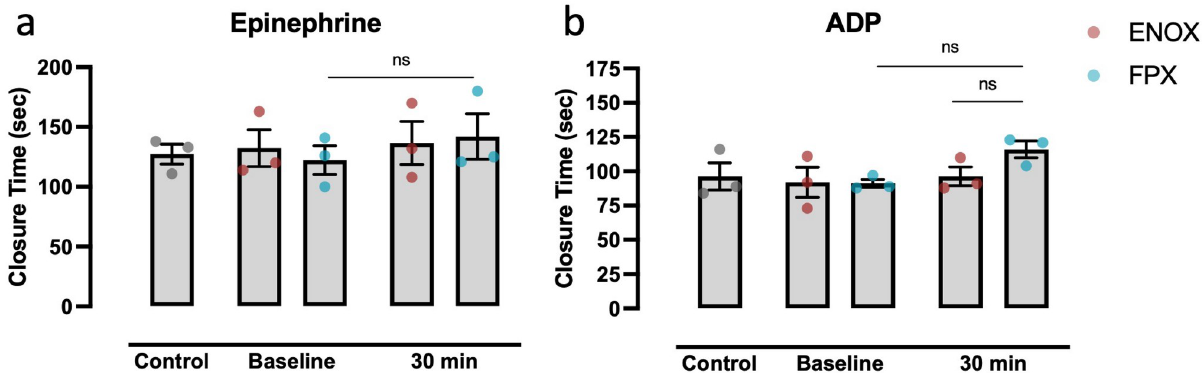
Fig 4. Preservation of platelet function at baseline and after incubation for 30 minutes. Measurements of thrombocyte function and initial platelet- thrombus formation were performed employing a routinely used platelet function assay (PFA). Therefore, anticoagulated blood was stimulated with epinephrine (a) or ADP (b) on a collagen-coated surface. For control values, freshly drawn blood was only anticoagulated with 3.8% citrate. PFA was also performed with citrated blood plus either fondaparinux (FPX) or enoxaparin (ENOX), both freshly drawn (Baseline) and after 30 minutes of incubation (30 min) in MPC-coated tubes. For statistical analysis, RM one-way ANOVA with Geisser-Greenhouse correction was performed, using Tukey’s post-hoc testing with adjustment for multiple comparisons. Values are presented as mean ± s.e.m. All samples: n =